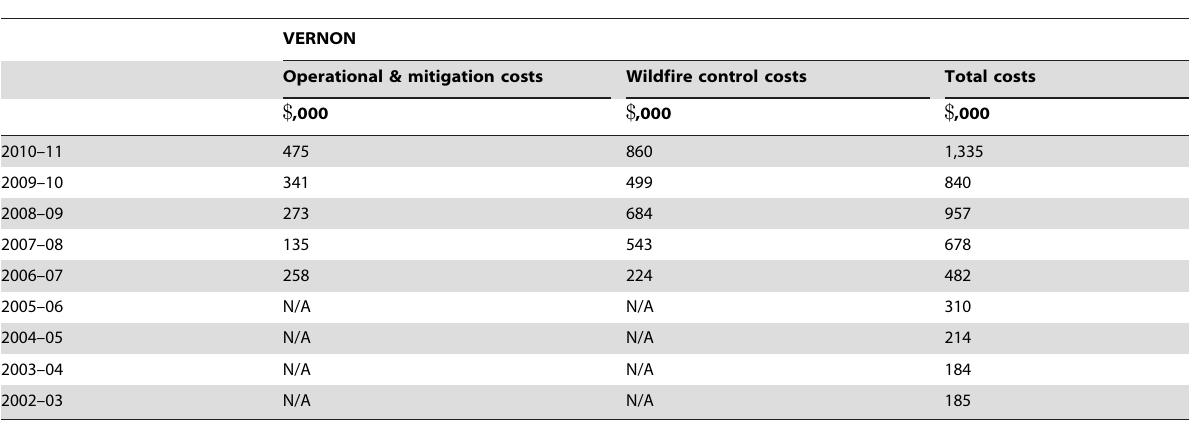
Table 5. Fire management costs in the Vernon Fire Control region (2002–2011).